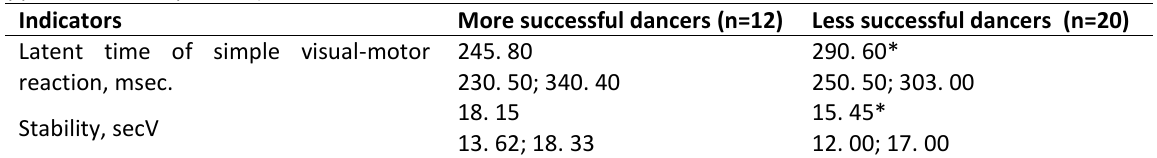
Table 3. Indicators of latent time of simple visual-motor reaction of dancers with different successfulness (median, upper and lower quartiles) Indicators More successful dancers (n=12) Less successful dancers (n=20) Latent time of simple visual-motor reaction, msec. Stability,